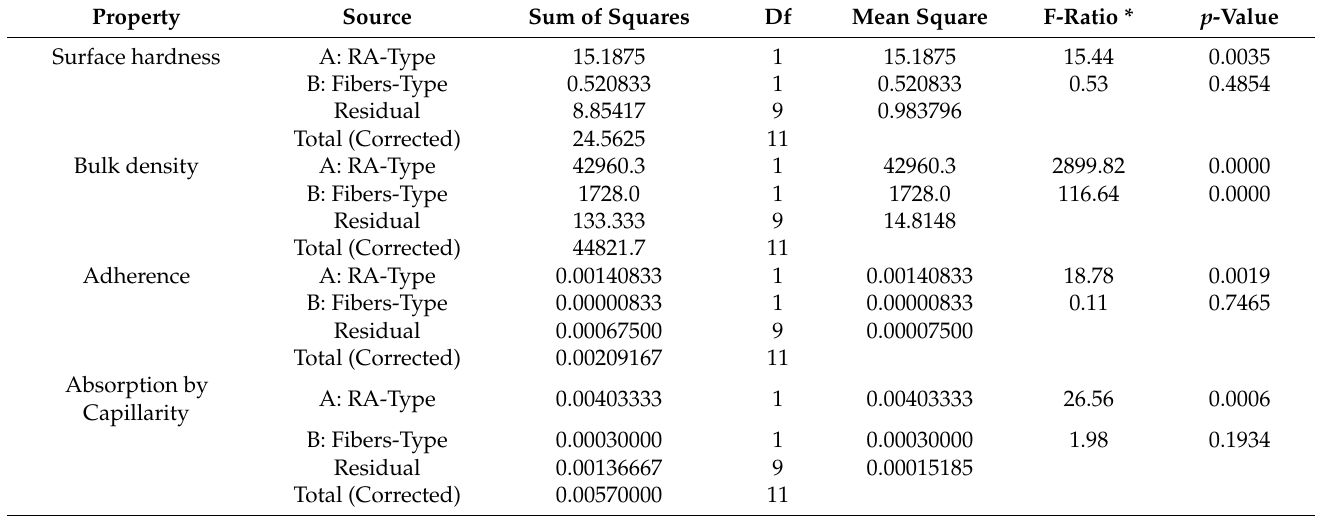
Table 14. Analysis of variance for physical